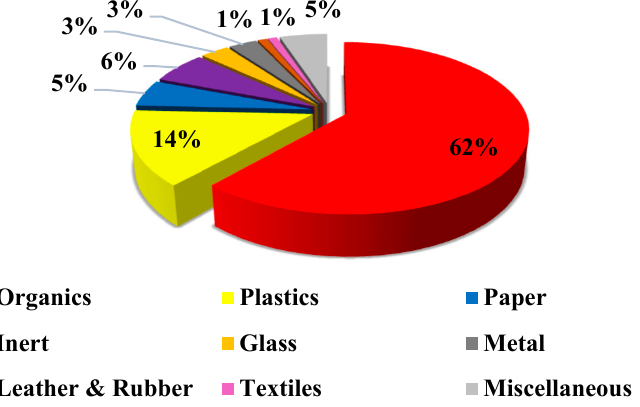
Figure 2. Estimated composition of MSW in Ghana [20].